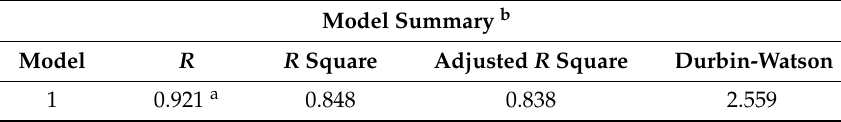
Table 5. Compliance with the assumption of no